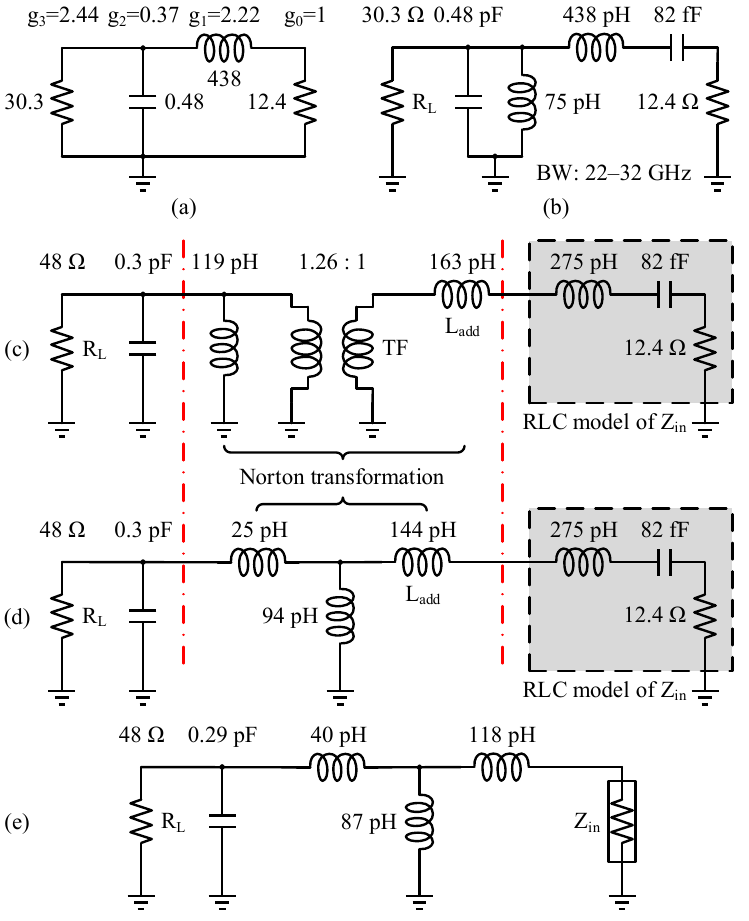
Figure 13. IMN design flow: ( a ) low-pass prototype; ( b ) band-pass version; ( c ) upward impedance transformation of R L to 48 Ω ; ( d ) Norton transformation to remove the ideal transformer; ( e ) opti- mized band-pass network.